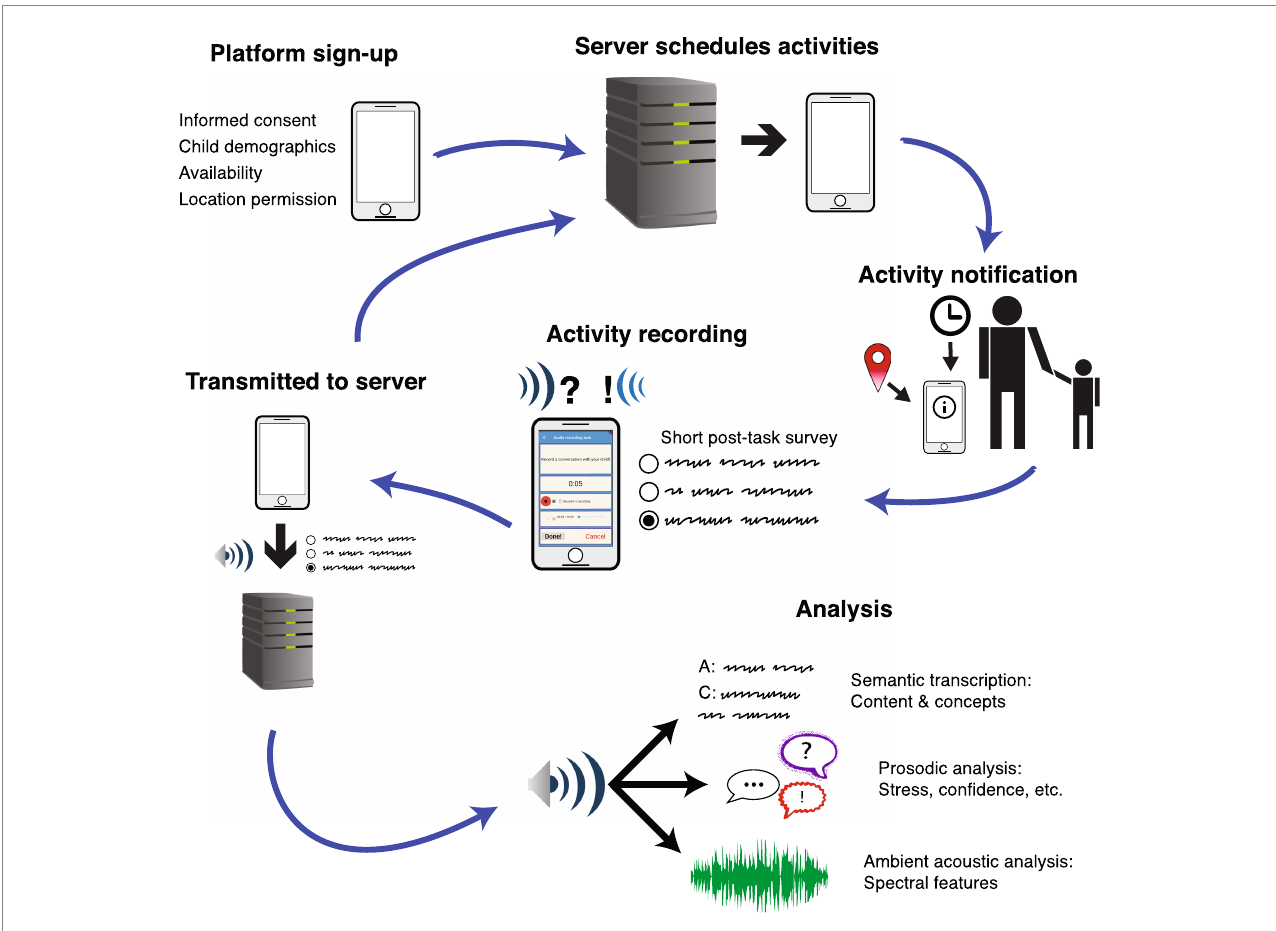
FIGURE 1 Summary of the workflow of the Talk of the Town platform, from initial sign-up to data analysis. See text for more detailed descriptions of each